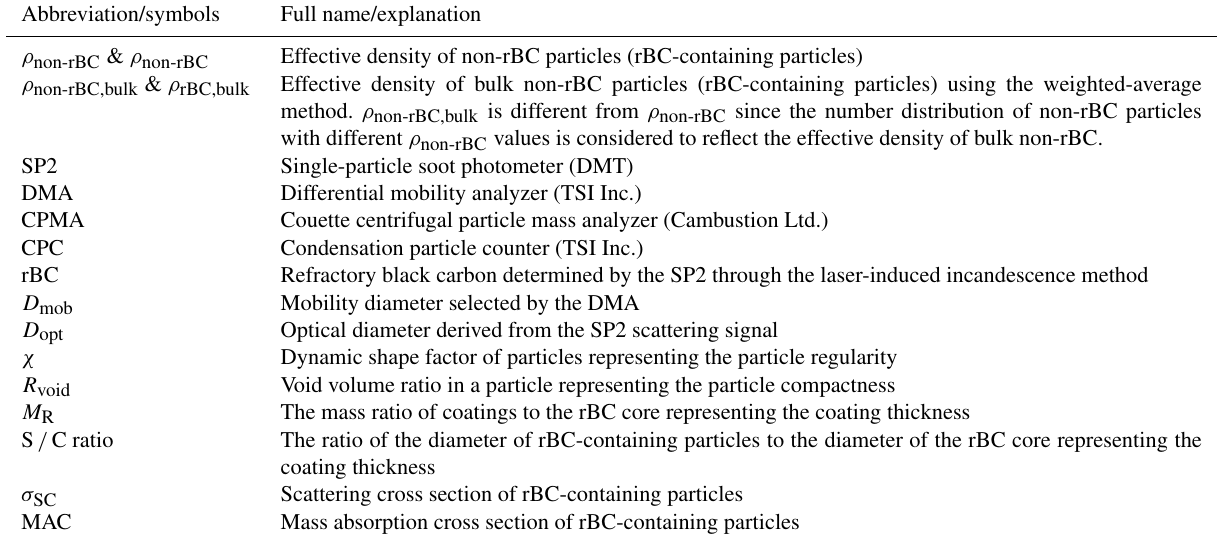
Table 1. Abbreviations and symbols used in this